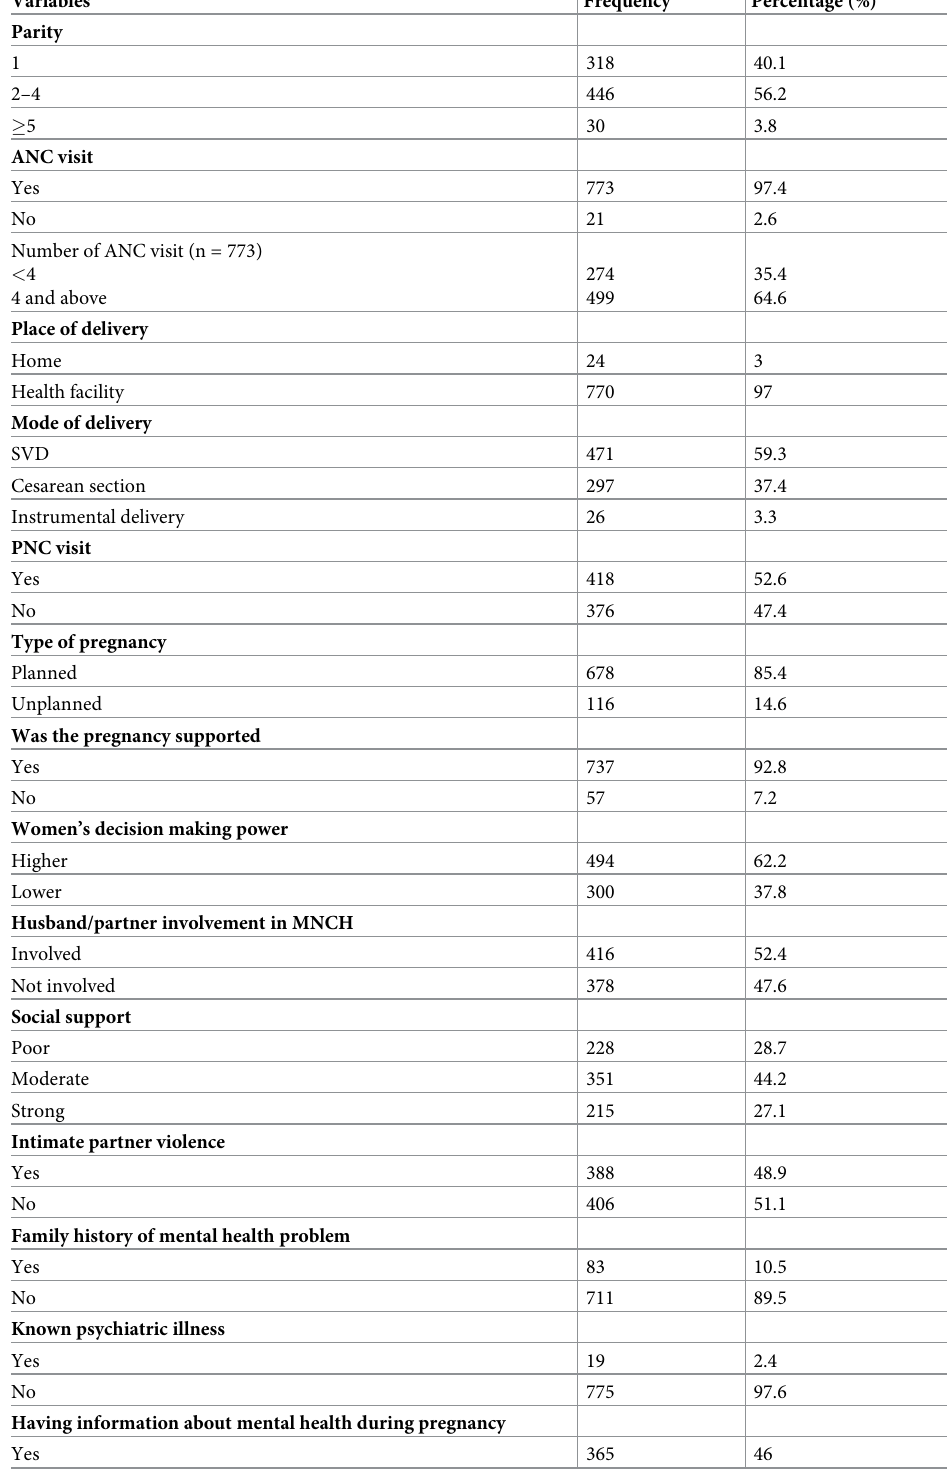
Table 2. Obstetrics, medical related and maternal health service characteristics of women who gave birth in the last one year in Gondar city, northwest Ethiopia, 2021 (n =